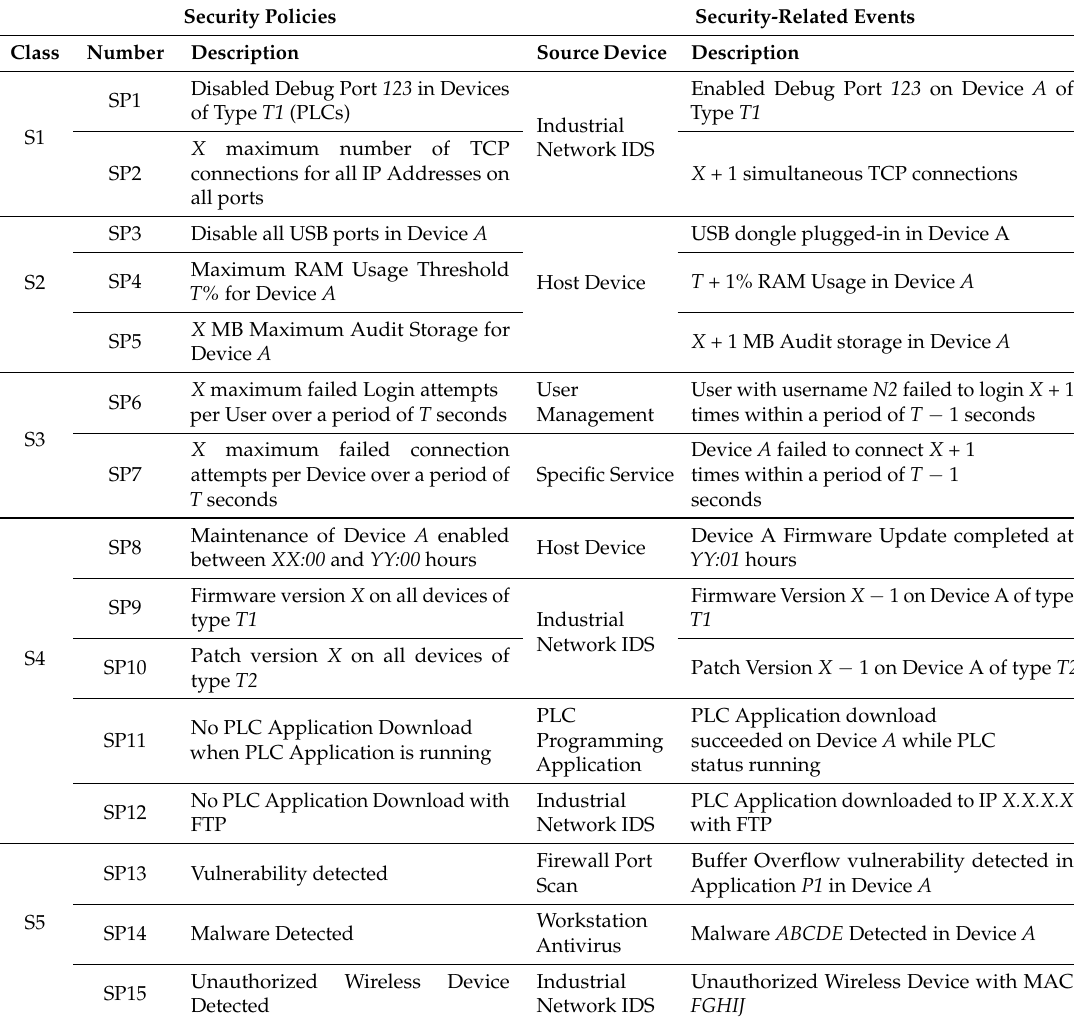
Table 3. Examples of Security Policies (SP) and their security-related